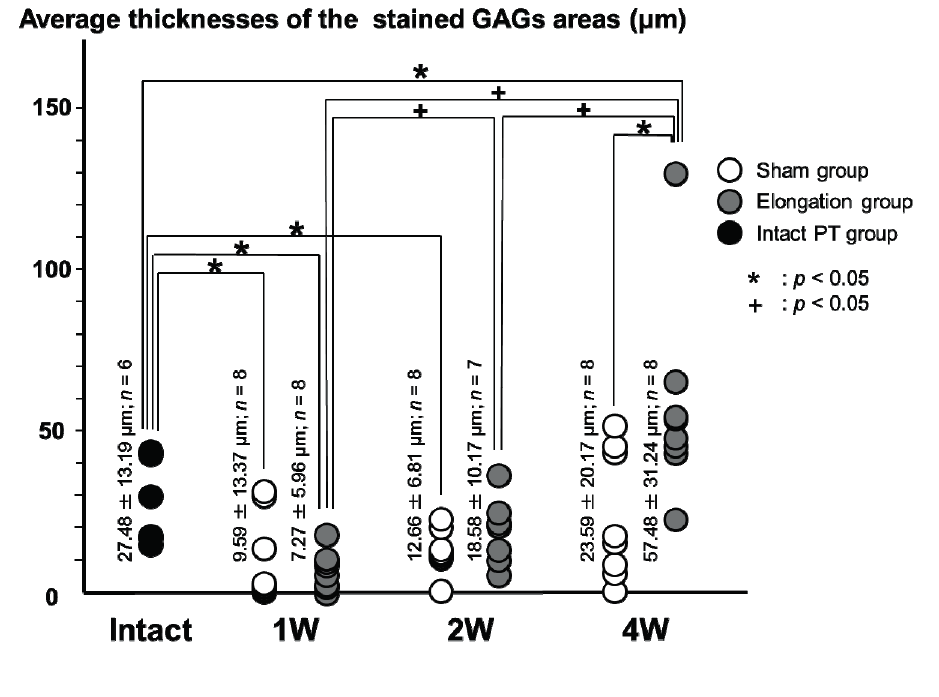
Figure 6. Average thicknesses of the stained GAGs areas in the uncalcified fibrocartilage layer. The average thickness of the stained GAGs areas in the elongation group at 4 weeks was significantly higher than that in the sham group at 4 weeks ( p = 0.011). In the elongation group, the average thicknesses of the stained GAGs areas at 2 and 4 weeks were higher than that at 1 week ( p = 0.009 and p < 0.001, respectively). In the elongation group, the average thickness of the stained GAGs areas at 4 weeks was higher than that at 2 weeks ( p = 0.004). The average thickness of the stained GAGs areas in the elongation group at 4 weeks was significantly higher than that in the intact PT group ( p = 0.024). The average thicknesses of the stained GAGs areas in the elongation group at 1 week and the sham group at 1 and 2 weeks was significantly lower than that in the intact PT group ( p = 0.001, 0.014 and 0.009,